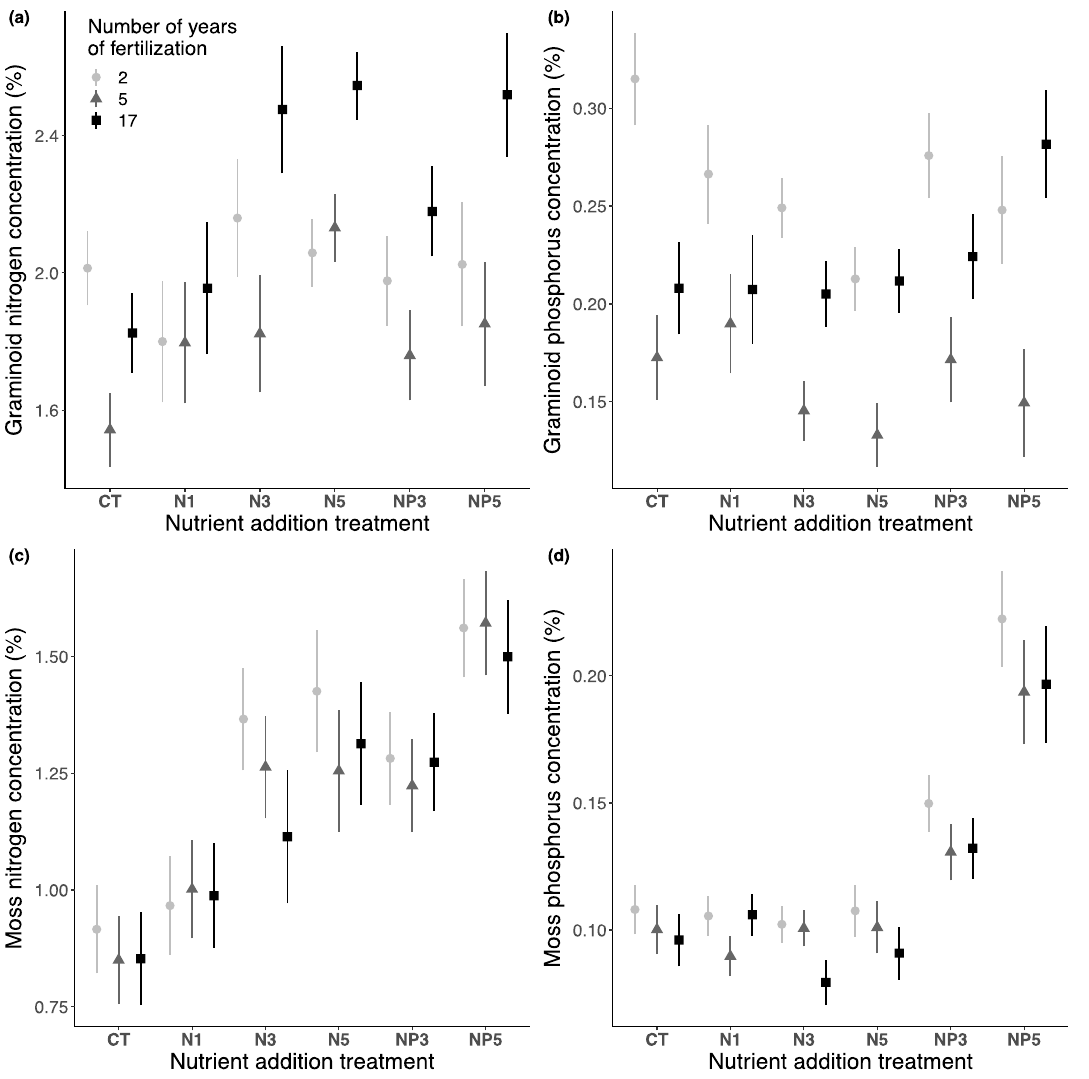
Figure 6. ( a ) Nitrogen concentration and ( b ) phosphorus concentration of graminoid leaves and stems, and ( c ) nitrogen concentration and ( d ) phosphorus concentration of mosses according to fertilization treatments after 2, 5, and 17 years of experimentation in the tundra wetlands at Bylot Island, Nunavut. Least square means ± SE are presented. See methods for definition of treatments.